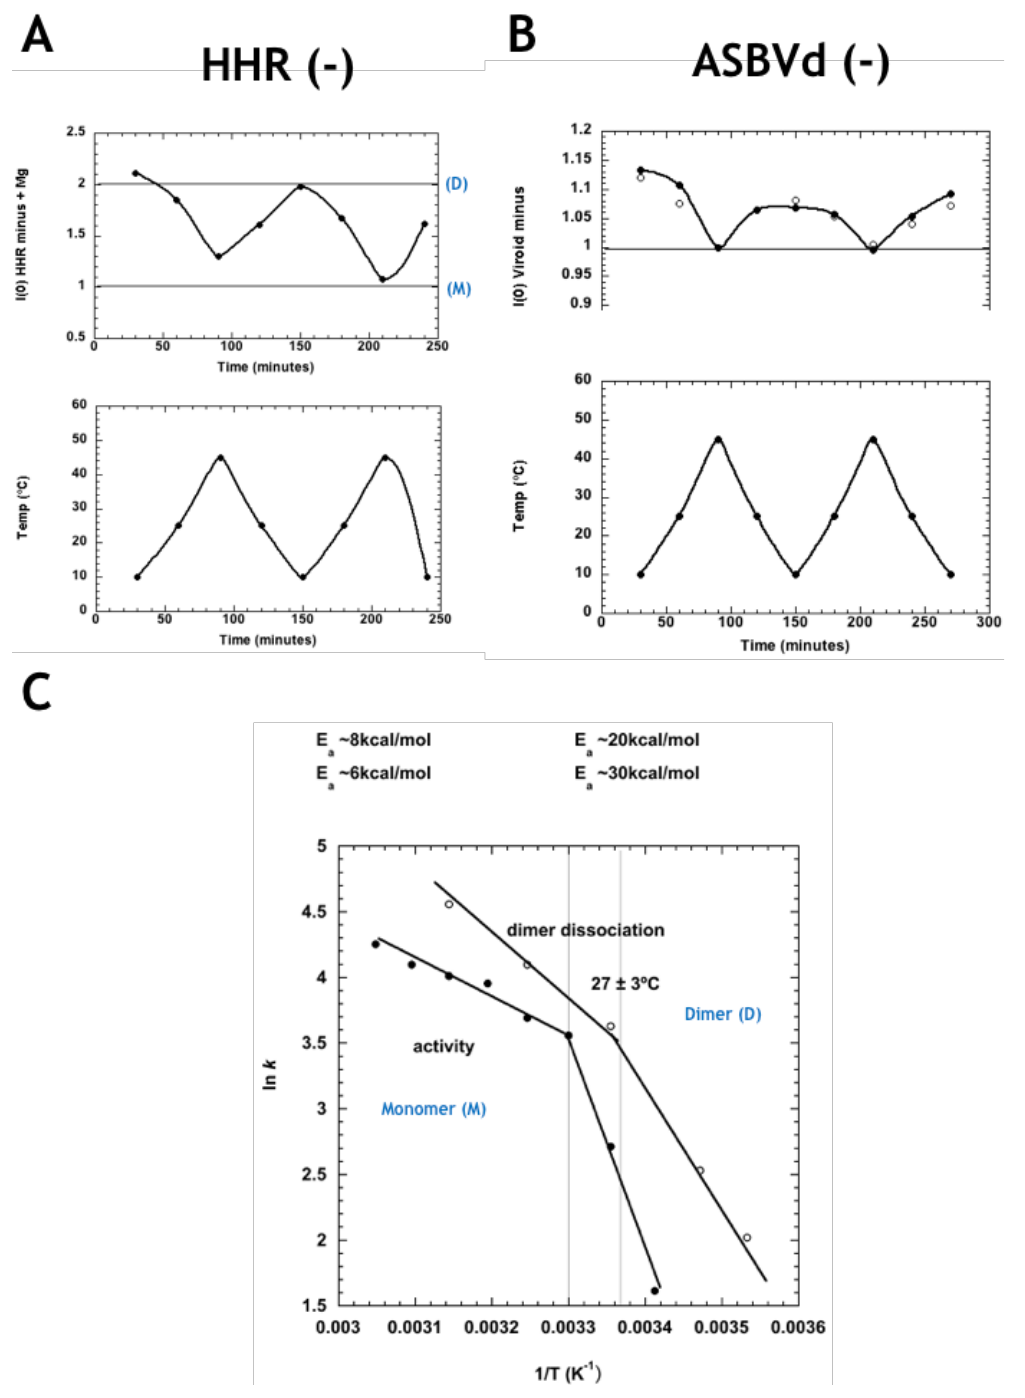
Figure 3. ( A ) Normalized forward scattered small-angle neutron scattering (SANS) intensity for HHR ( − ) in the presence of Mg++ at the corresponding temperature on the plot below. The values at 1.00 and 2.00 correspond to the intensity expected for the monomer (M) and dimer (D), respectively. ( B ) Normalized forward scattered SANS intensity for ASBVd ( − ) in presence (filled circles) and absence (open circles) of Mg++, at the corresponding temperature on the plot below. The data indicate a small amount of dimer formation at the lower temperature. ( C ) Arrhenius plots of HHR ( − )/Mg rate of dimer dissociation (open circles, calculated from (A), and the ribozyme’s catalytic activity (filled circles), revealing parallel behaviour. Modified from Leclerc et al.